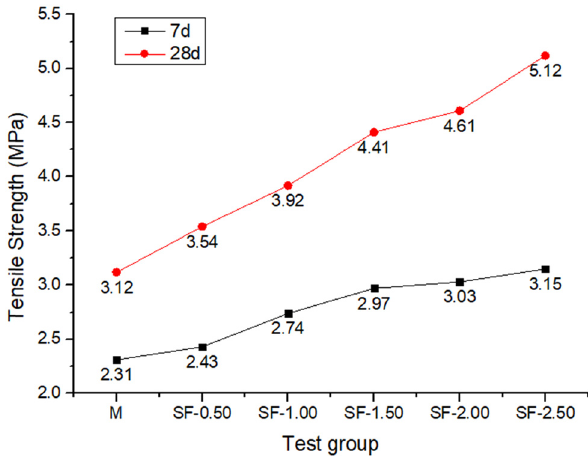
Figure 17: Tensile strength test results.